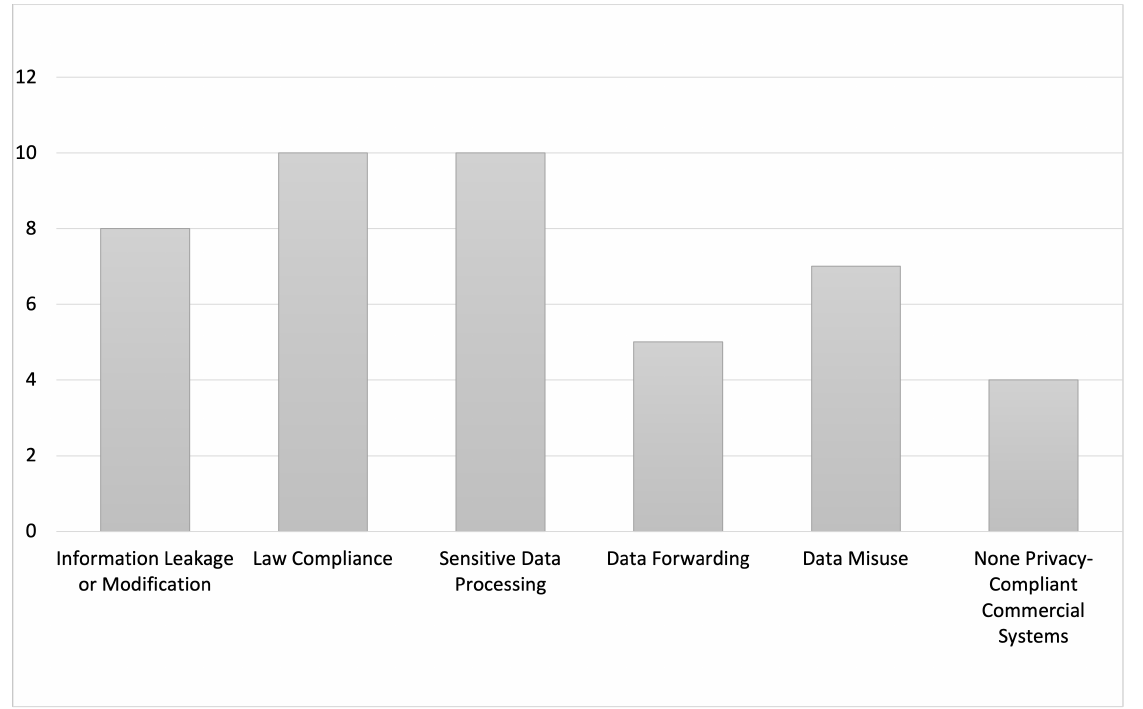
Figure 3. Reasons why privacy is implemented in ATTS in terms of frequency of